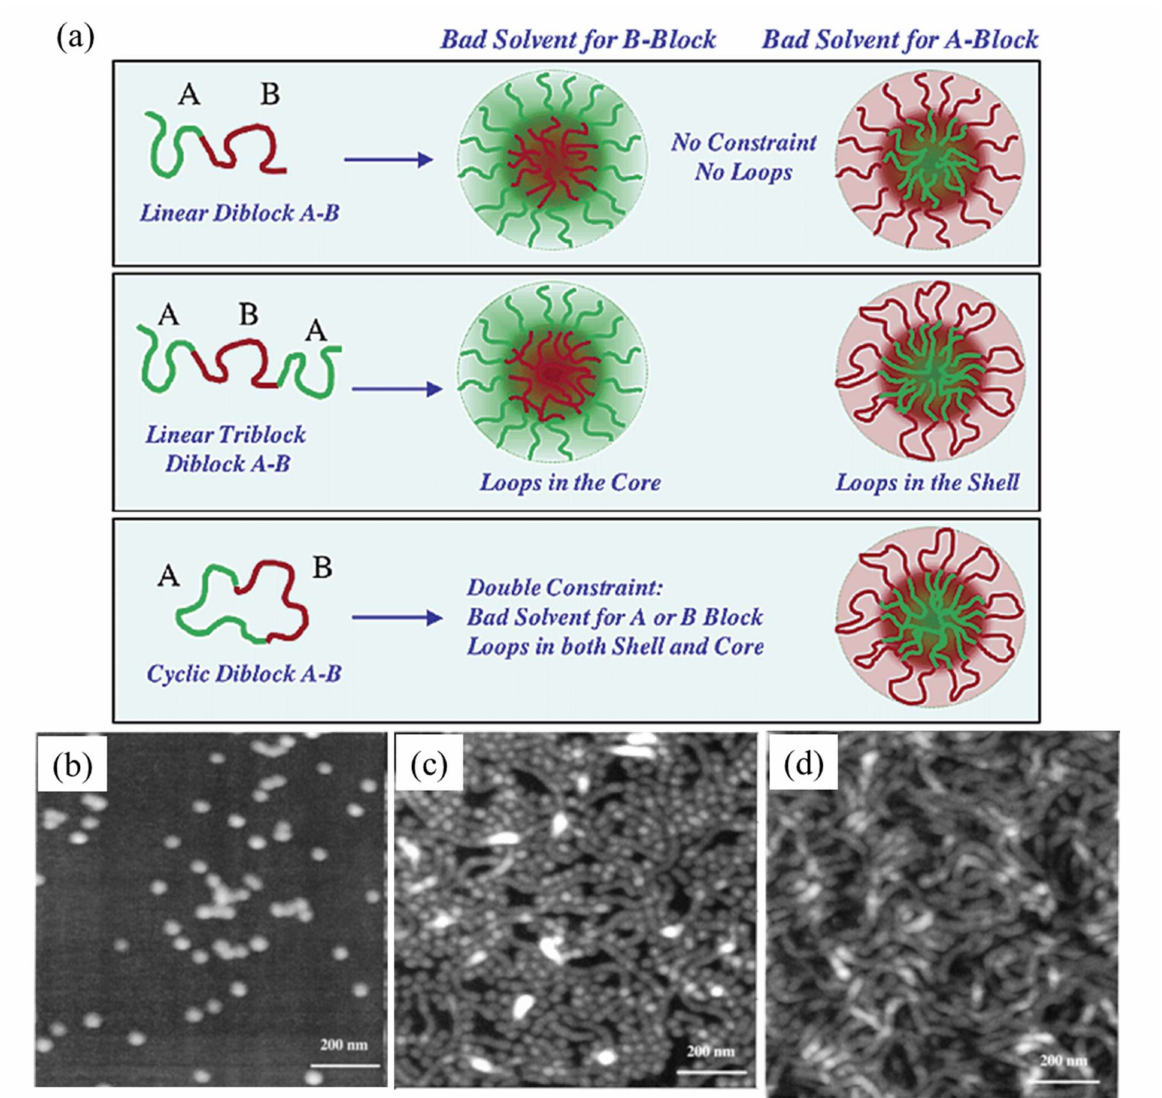
Figure 3. ( a ) schematic representation of topological constraints on the micelle using linear diblock (A-B), linear triblock (A-B-A), and cyclic diblock (A-B) polymers. AFM topographic images of PS-PI micelles in heptane at concentrations ( b ) 0.1 mg/mL, ( c ) 1 mg/mL, and ( d ) 5 mg/mL. Reprinted with permission from [53]. Copyright 2003 American Chemical